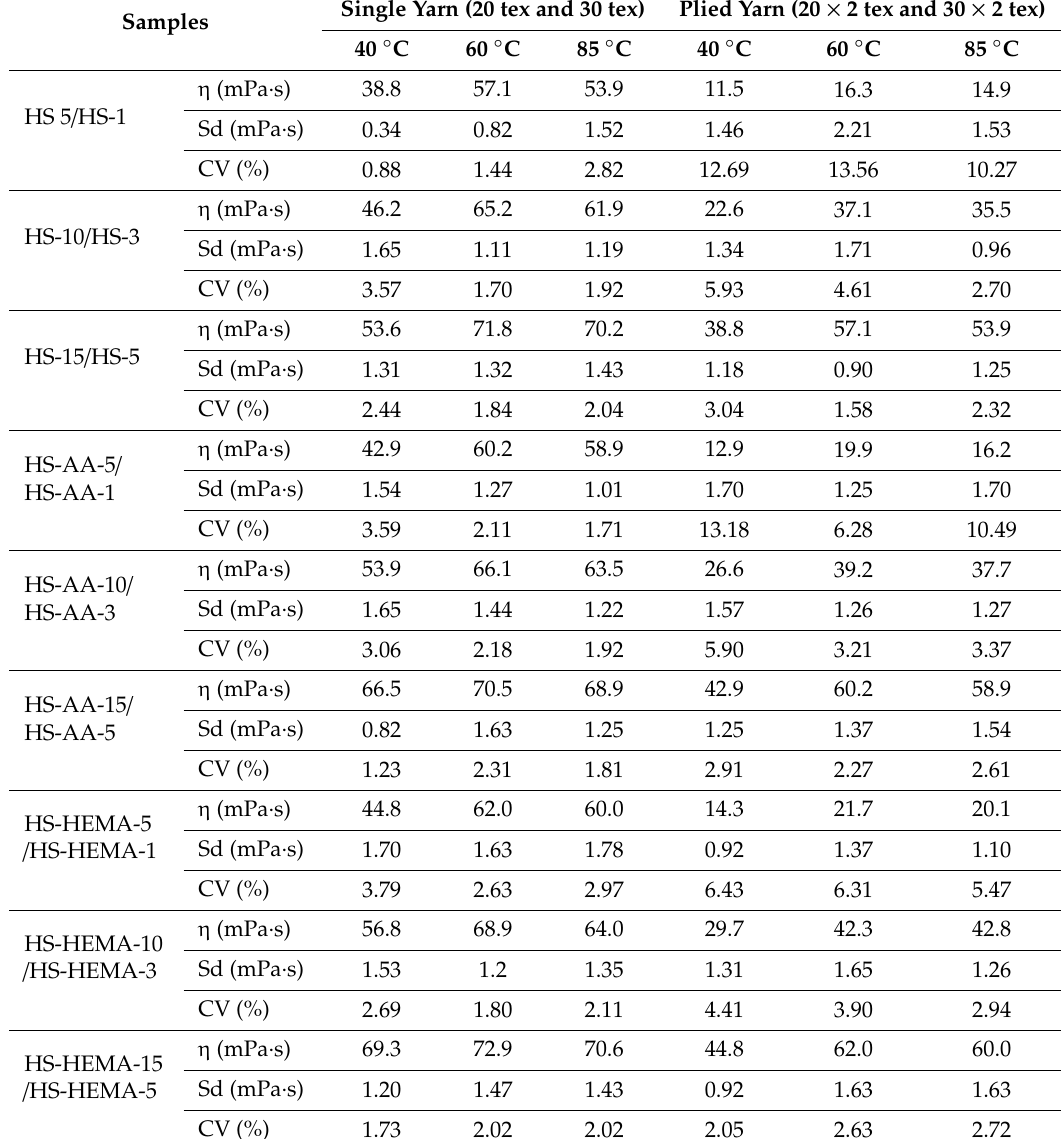
Table 6. Size viscosity η (mPa · s) at di ff erent concentrations; spindle speed 60 rpm, time—15 min to 40 ◦ C; 20 min to 60 ◦ C and 30 min to 85 ◦